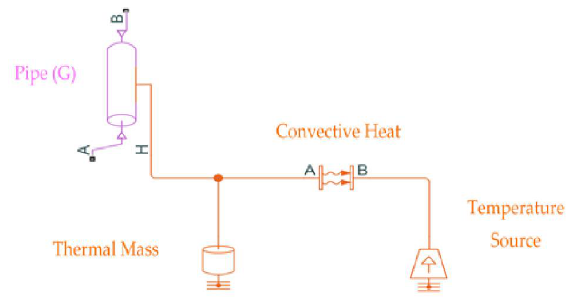
Figure 3. The SimScape model of the pipe.